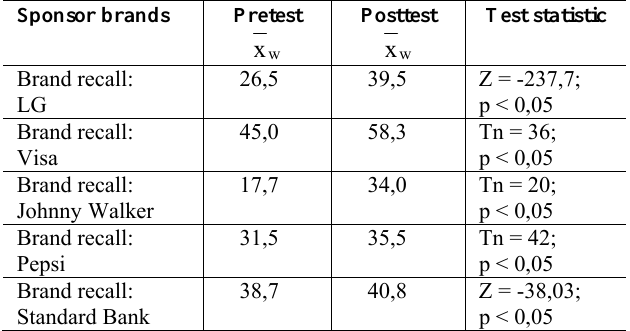
Table 1: Brand recall: sponsor brands Sponsor brands